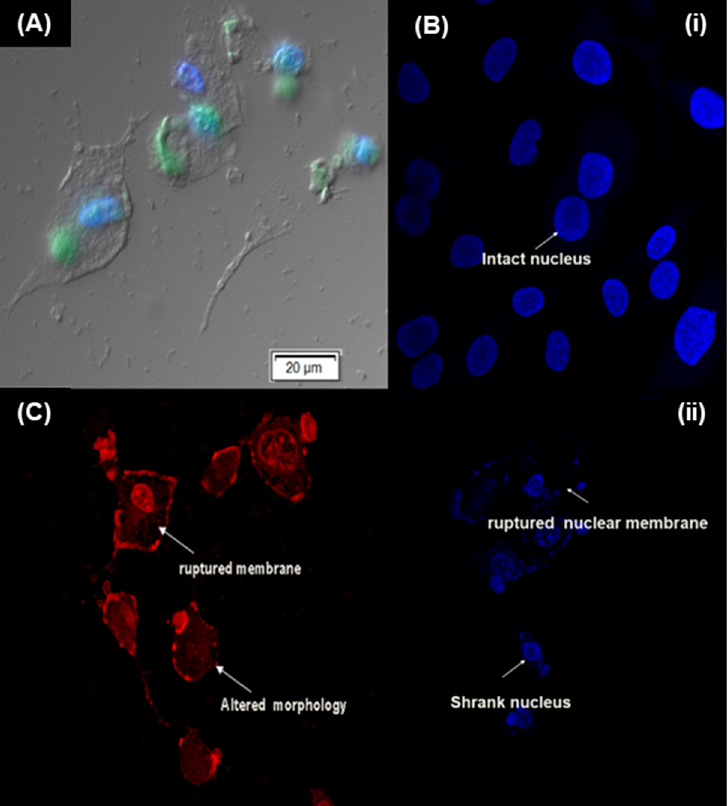
Figure 6. Effects of LyP-1-modified nanosystem on KYSE-30 nuclear and mitochondrial integrity. ( A ) Differential interference contrast (DIC) micrographs showing subcellular co-localization of the LyP-1-functionalized ENT-loaded nanosystem in the nuclei of KYSE-30 cells stained with DAPI. ( B ) CLSM images of the nucleus of KYSE-30 cells stained with DAPI: ( i ) untreated KYSE-30 cells; ( ii ) KYSE-30 cells pre-incubated with the LyP-1-functionalized ENT-loaded nanosystem. Depleted nuclear membrane showed signs of apoptosis and necrosis. ( C ) CLSM images of mitochondria stained with rhodamine 123 in live KYSE-30 cells. Altered-configuration of the mitochondrial morphology and disrupted mitochondrial membrane showed apoptosis [29].